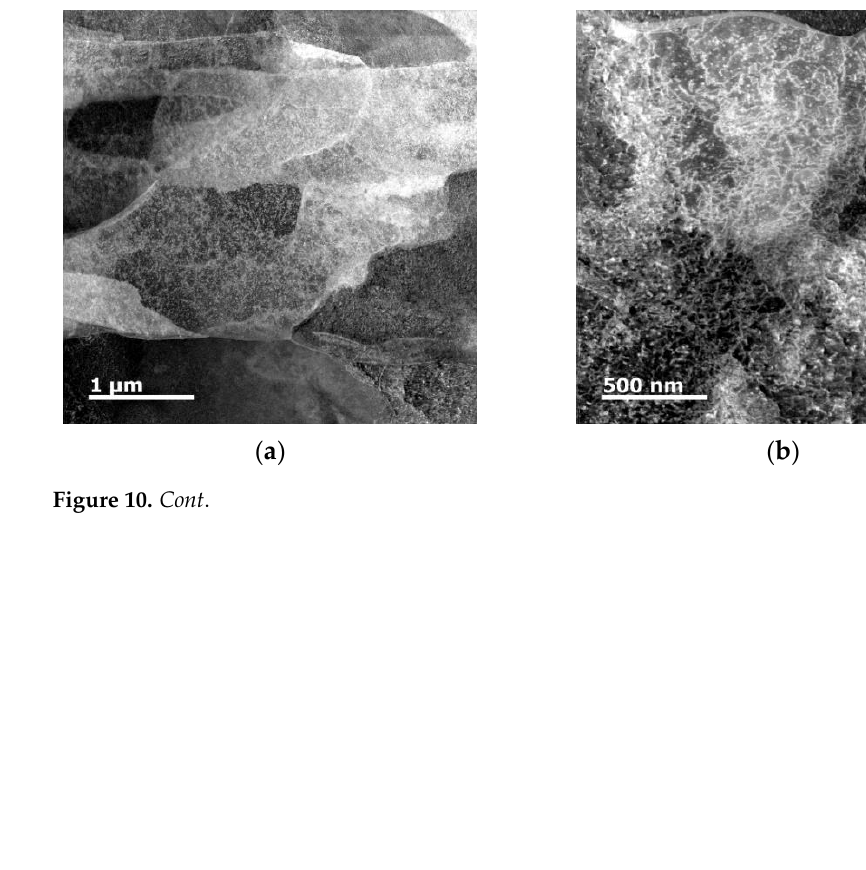
Figure 9. Inverse pole figures (IPFs) for Cu lamellas of swaged clad composites: ( a ) 20 mm; ( b ) 15 mm; ( c ) 10 mm; ( d ) IPFs for Al matrices of swaged clad composites: 20 mm; ( e ) 15 mm; ( f ) 10 mm.